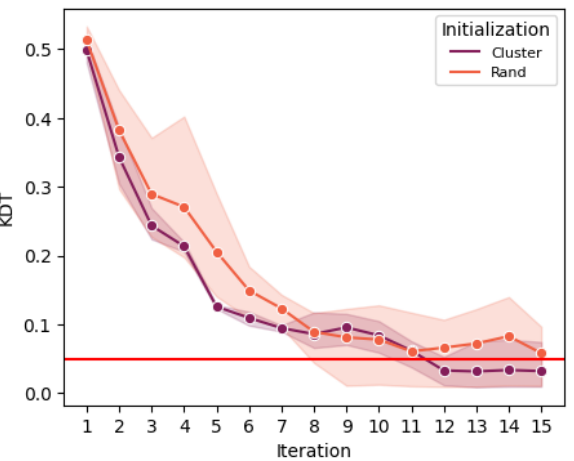
Figure 3. Learning curve of problem PF3 varying the selection of the alternatives between cluster or at random.